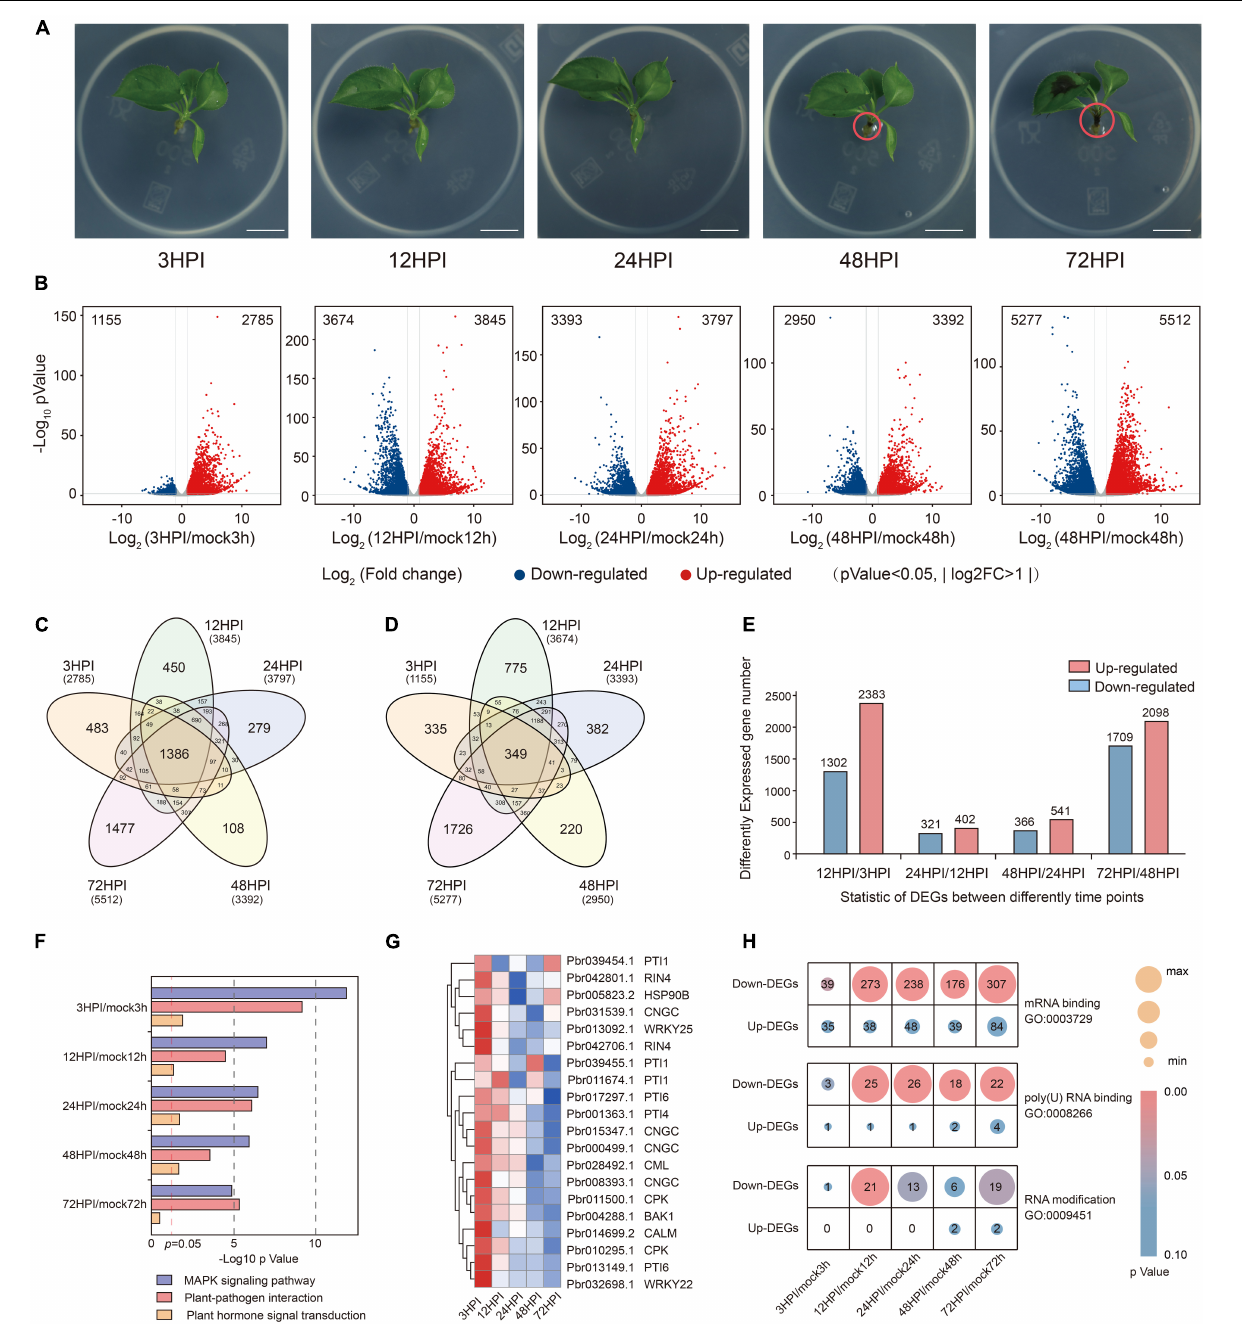
Frontiers in Microbiology |